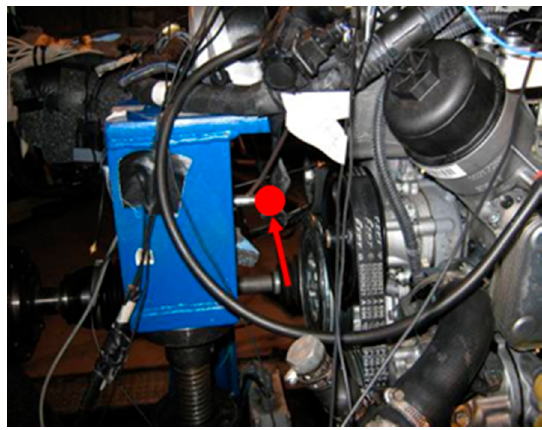
Figure 5. Near-field microphone.